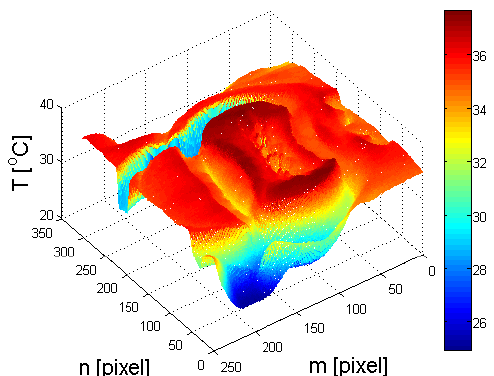
Figure 3. An example of a thermal image made before the test.